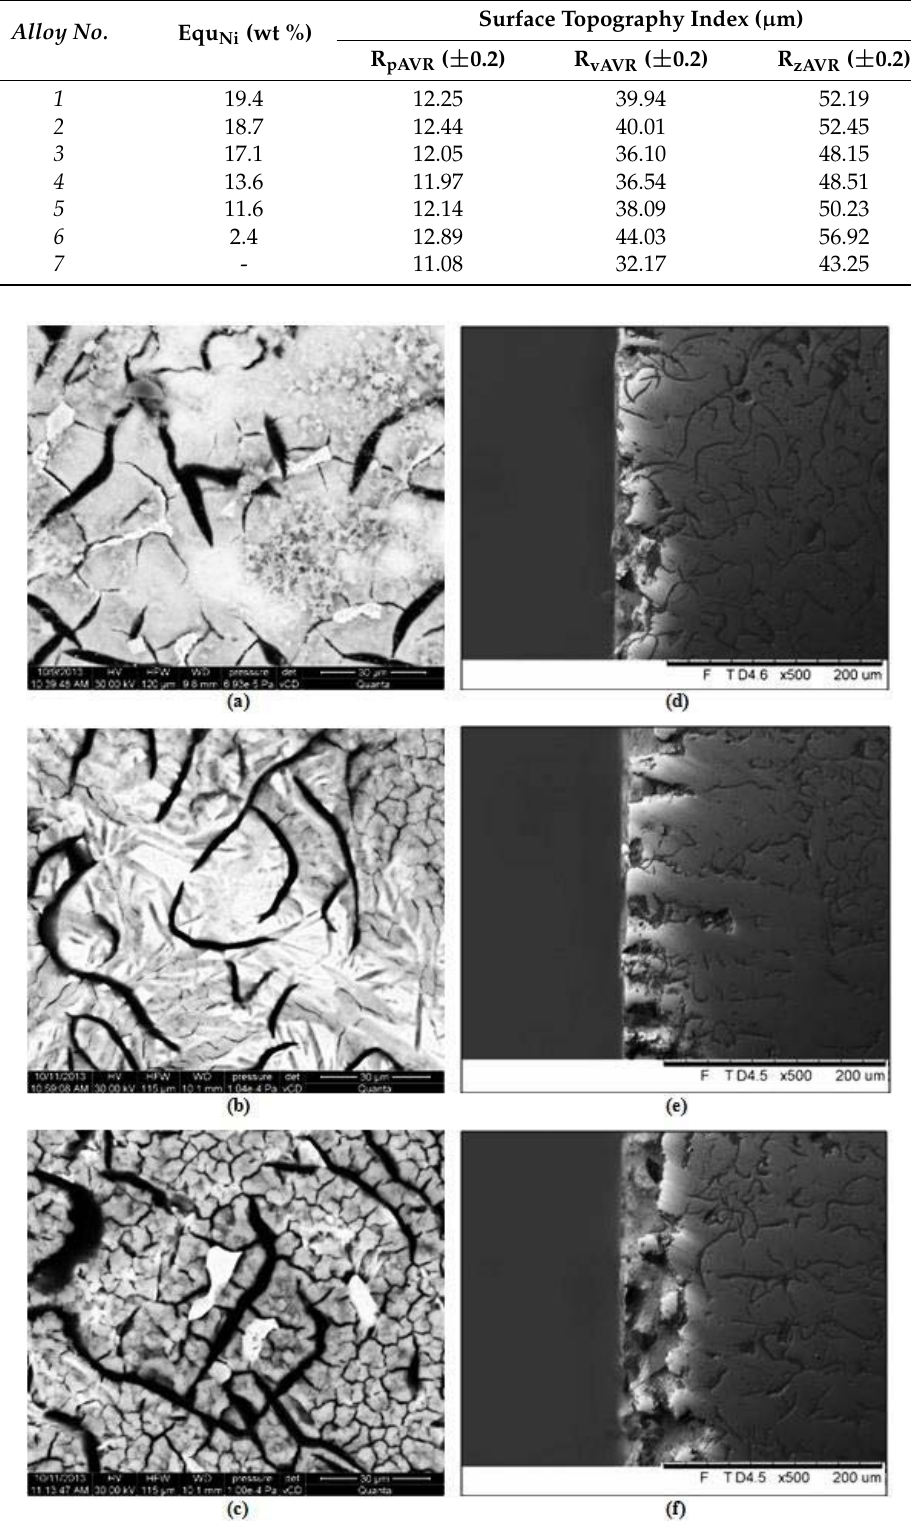
Figure 7. Face surfaces ( a – c ) and cross-sections ( d – f ) of specimens of the alloys No. 2 ( a , d ), 5 ( b , e ) and 6 ( c , f ) after potentiodynamic tests, exposed previously for 24 h in 3% solution of NaCl.